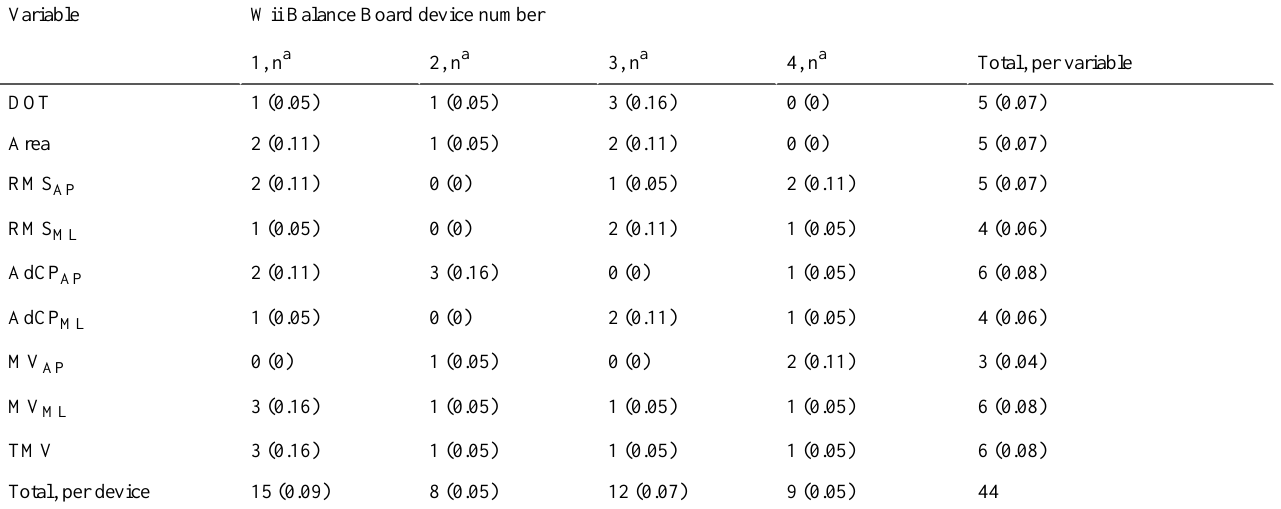
Table 2. Contingency table of the number of observations outside of the confidence interval. Wii Balance Board device